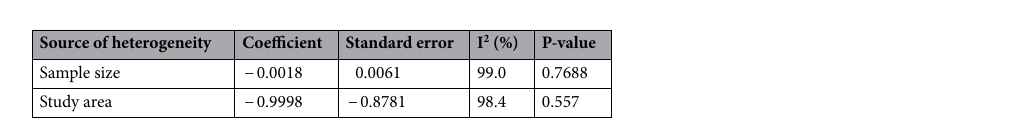
Figure 3. Funnel plot for the selected studies.